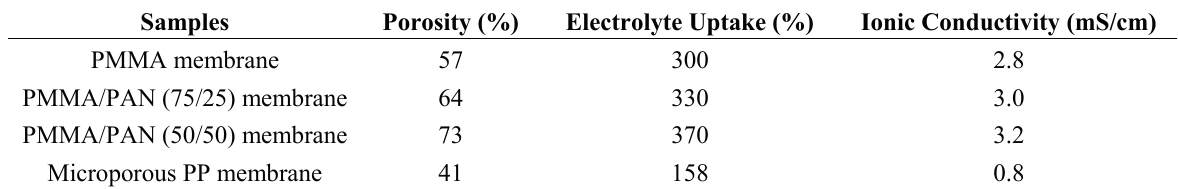
Table 1. Porosities, electrolyte uptakes and ionic conductivities of PMMA membrane, PMMA/PAN (75/25) membrane, PMMA/PAN (50/50) membrane, and microporous PP membrane at room